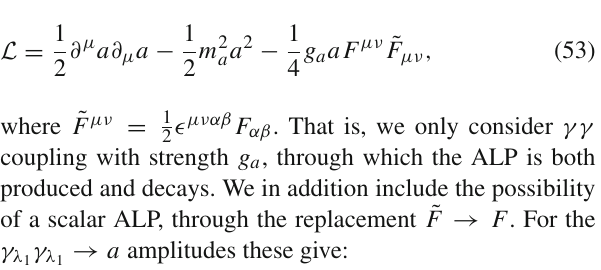
Fig. 7 Diphoton invariant mass distribution due to QCD and photon-initiated CEP in pp collisions at shows the individual contributions from fermion and W loops to the γγ -initiated process, while the right plot shows the impact of including finite fermion